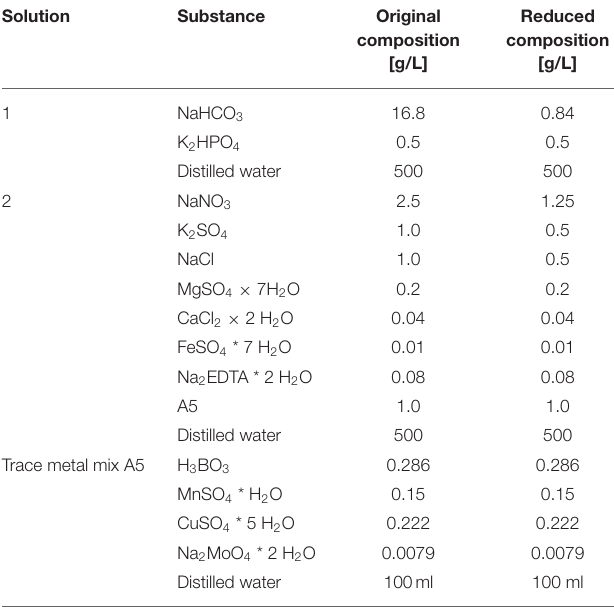
TABLE 1 | Medium composition used in this study for the SOT medium with original composition and reduced